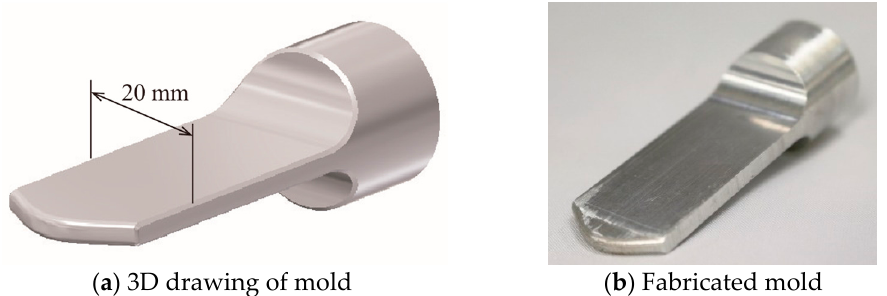
Figure 7. Three-dimensional drawing and photograph of duralumin mold for PI film molding: ( a ) 3D model of mold; ( b ) photograph of fabricated mold.